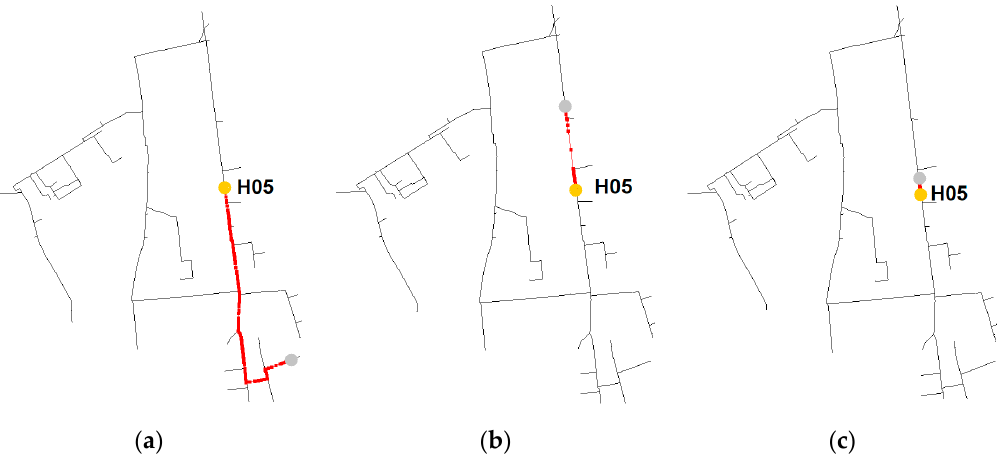
Figure 15. Length of the error for open hydrant H05: ( a ) length of the error equal to 762 m, ( b ): 234 m, and ( c ): 13 m.